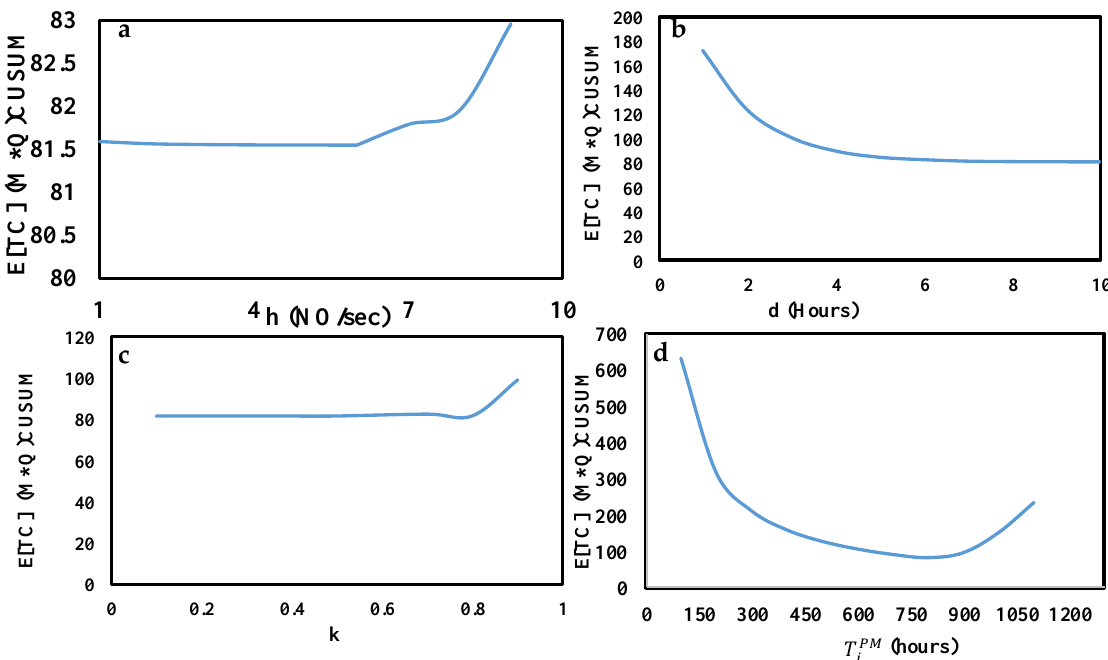
Figure 5. The impact of selected decision parameters on the expected total cost. ( a ) illustrates the impact of sample frequency (h) on the anticipated total cost, ( b ) the anticipated total cost decrease w i th the increase in decision interval (d), ( c ) the expected cost variations w i th the change in the control limit coefficient (k), ( d ) the total cost decreases w i th the increase in PM interval until.